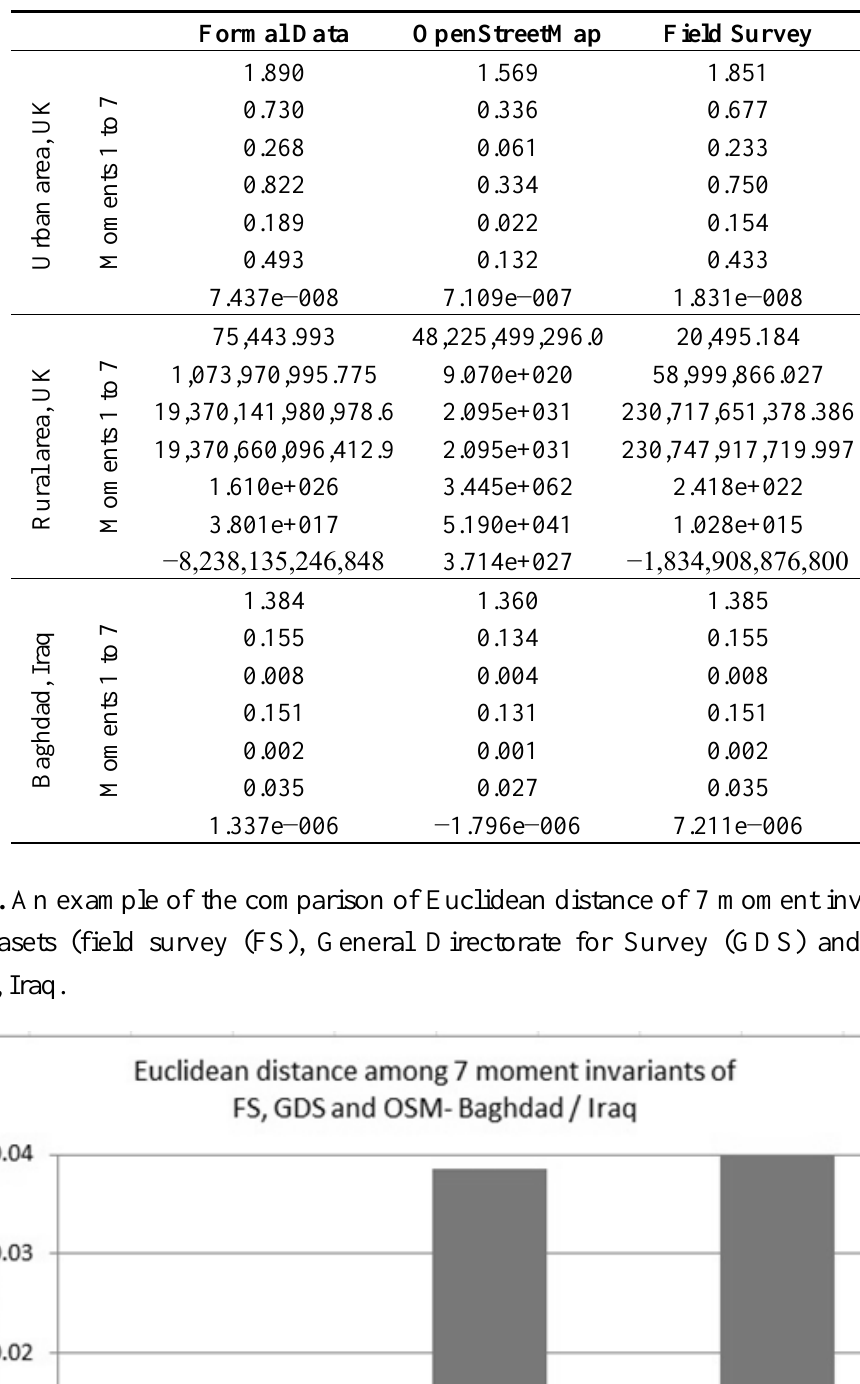
Table 4. Examples of moments invariant calculations from one polygon feature in each dataset.